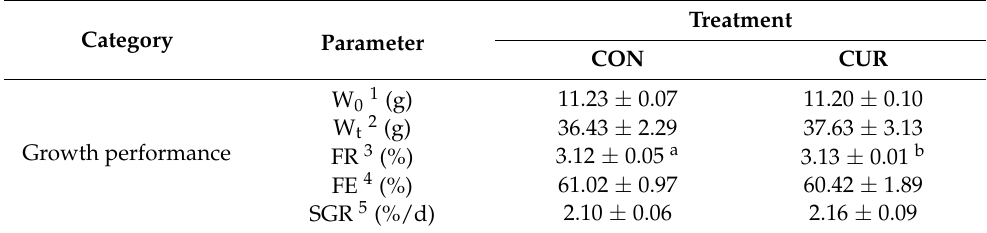
Table 1. Growth performance and whole fish composition of gibel carp after eight weeks of Curcumin (CUR) supplementation in the